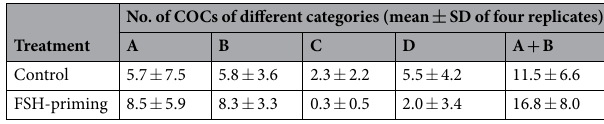
Table 2. Effect of FSH-priming on morphological quality of